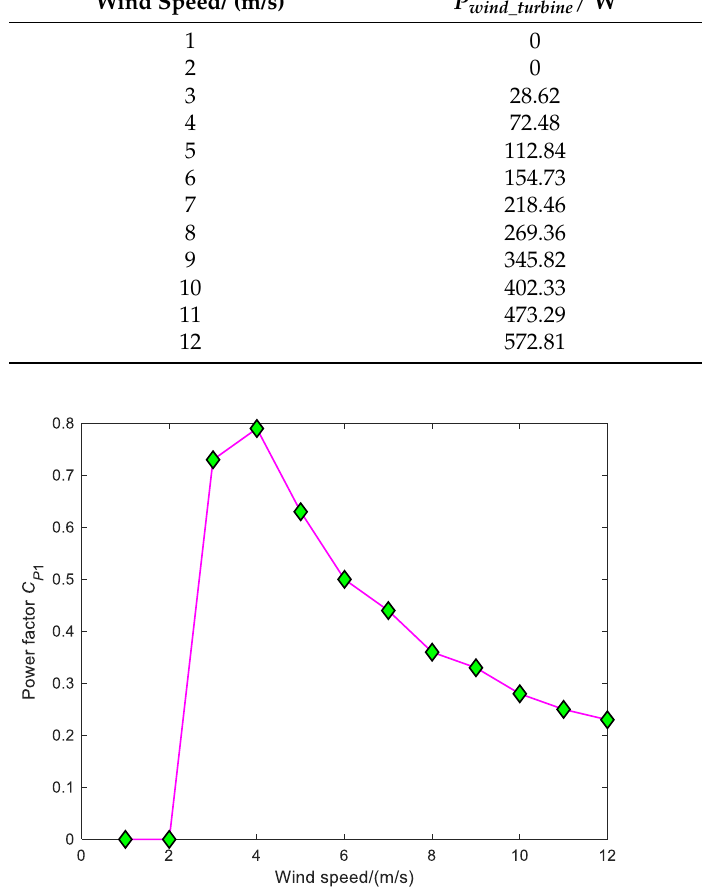
C . Figure 4. Line graph of C p 1 1 p C . 1 p